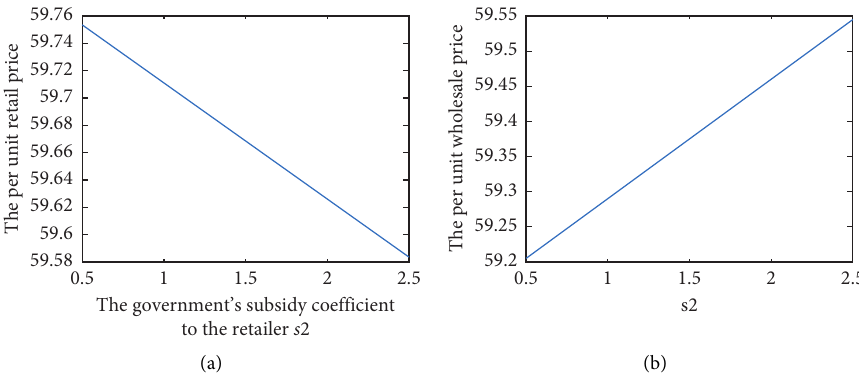
Figure 8: The effect of the government’s subsidy coefficient to the retailer s